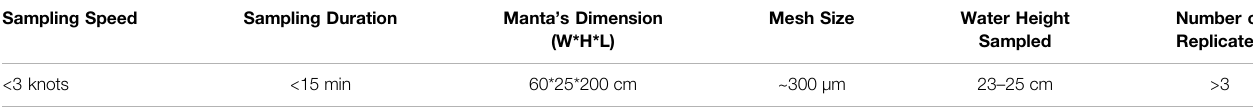
TABLE 1 | Recommended parameters while sampling with a Manta net according to the publications reviewed. W: width, H: height, L: net